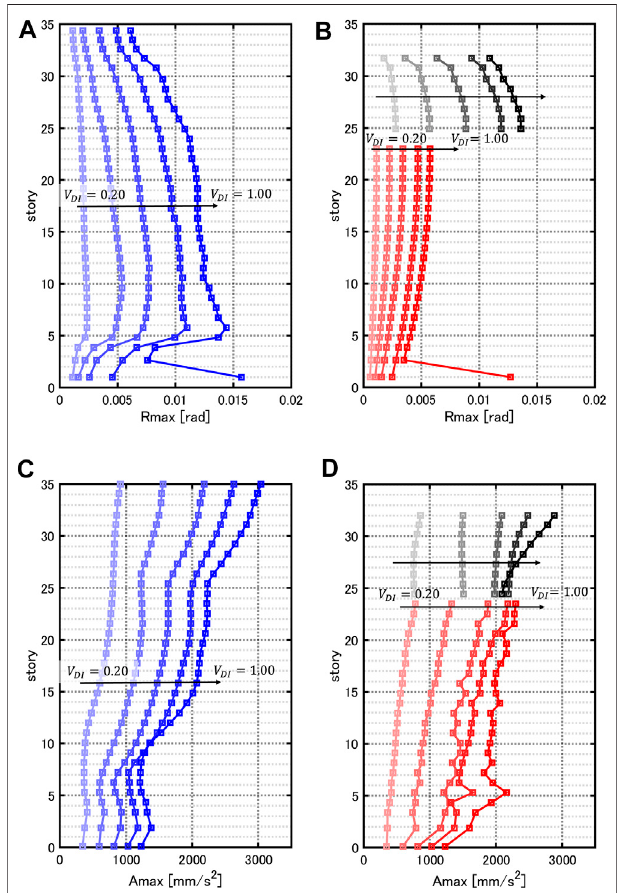
FIGURE5| Multiimpulsepushover(MIP)analysisofmaximuminterstory drifts and 5-cycle sinusoidal input analysis of maximum accelerations for elastic-plastic 3-D frame with deformation-concentration seismic control system ( V MI (cid:1) 0 . 10 ∼ 0 . 60 [ m / s ] with increment 0 . 10 [ m / s ] ), (A) Maximum interstory drift angle of main frame, (B) Maximum interstory drift angle of sub frame, (C) Maximum acceleration of main frame, (D) Maximum acceleration of sub